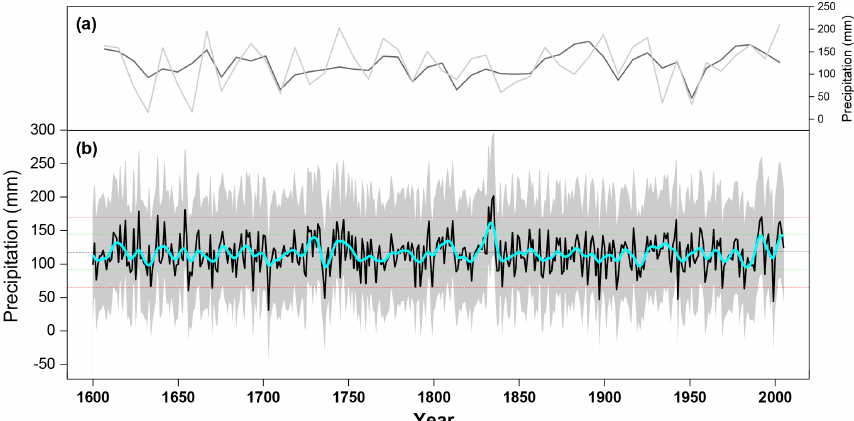
Figure 6. NGS precipitation reconstruction from 1600 to 2005. (a) The black line is the reconstruction series; the thick cyan line is the 11-year loess smoothed series. The horizontal dashed black line is the mean of NGS precipitation value during 1600–2005. The horizontal green and red dashed lines are 1 and 2 times the standard deviation of NGS precipitation, which demonstrated the boundaries of dry and extremely dry (below mean), and wet and extreme wet (above mean) years. The gray shading indicated the 95% confidence interval of the reconstruction; (b) instrumental (black) and reconstructed (gray) NGS precipitation during their common period of